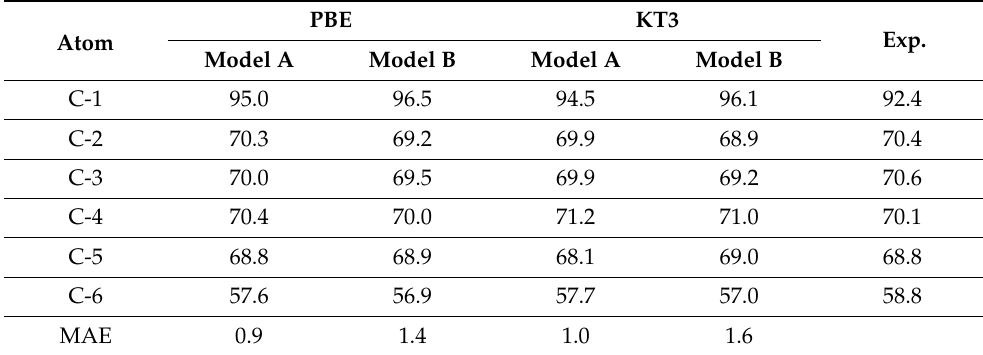
Table 2. 13 C-NMR isotropic chemical shifts of α -D-galactose ( 12 ) calculated using the PBE and KT3 functionals. Compiled from Kibalchenko et al.